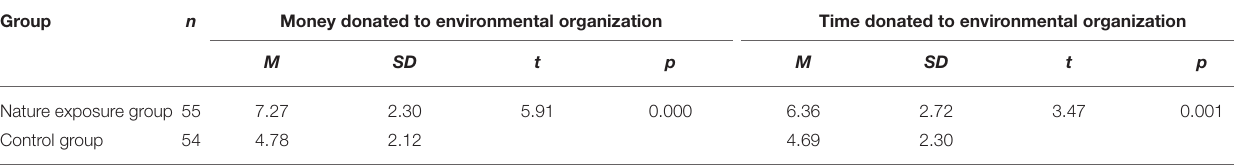
TABLE 4 | Comparison of pro-environmental behavior at different levels of nature exposure. Group